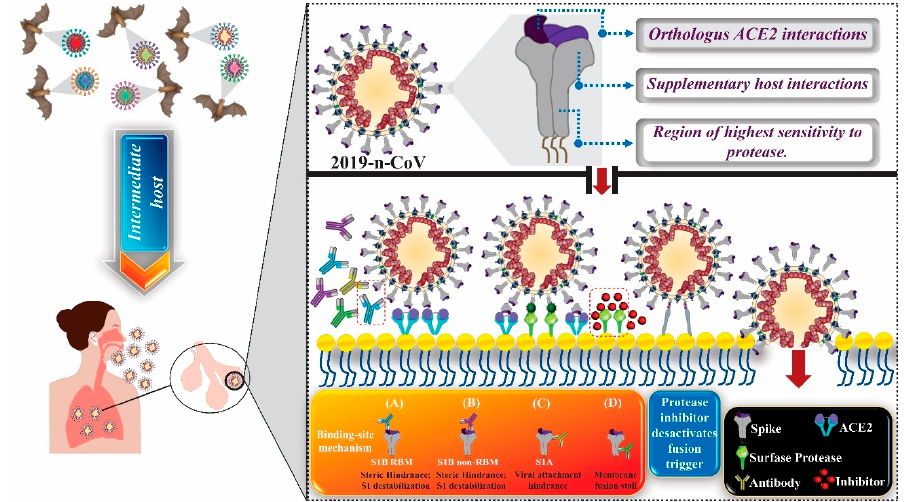
Figure 3. Infection of pneumococytes during COVID-19. It is assumed that CoVs that cause COVID-19 in humans are related to bats (upper left corner). This selected subset of viruses has the necessary resources to infect the human respiratory tract (lower left corner), with a certain tropism for this system. Infection (right panel) requires the interaction of spike proteins present in the SARS-CoV-2 viral envelope (S proteins) with host sites for type 2 angiotensin-converting enzyme (ACE2) present in the lung. Subsequently, proteases present on the surface of pneumocytes cleave the S2 region of the S protein, the subunit responsible for the fusion of the S protein with the cell membrane. After cleavage, a series of conformational changes are triggered, resulting in the fusion between viral envelope and the target cell membrane. The structural features of SARS-CoV-2 that can facilitate infection in humans include: (1) Presence of reasons for binding to the S1B receptor (RBMs) (in purple) that bind to ACE2 orthologous receptors. ACE2 is believed to be orthologous because it exhibits homology to S1B RBMs (since they complement each other to the point of binding) and were probably duplicated from a common ancestor, shared by the two underlying sister species, where in the course of evolution, both receptors gradually differentiate but continue to have affinity for each other; (2) An S1A domain that provides additional interactions with the host and; (3) A cleavage substrate for a furin protease (represented by the green starry shape bound to the protease at the bottom right of the